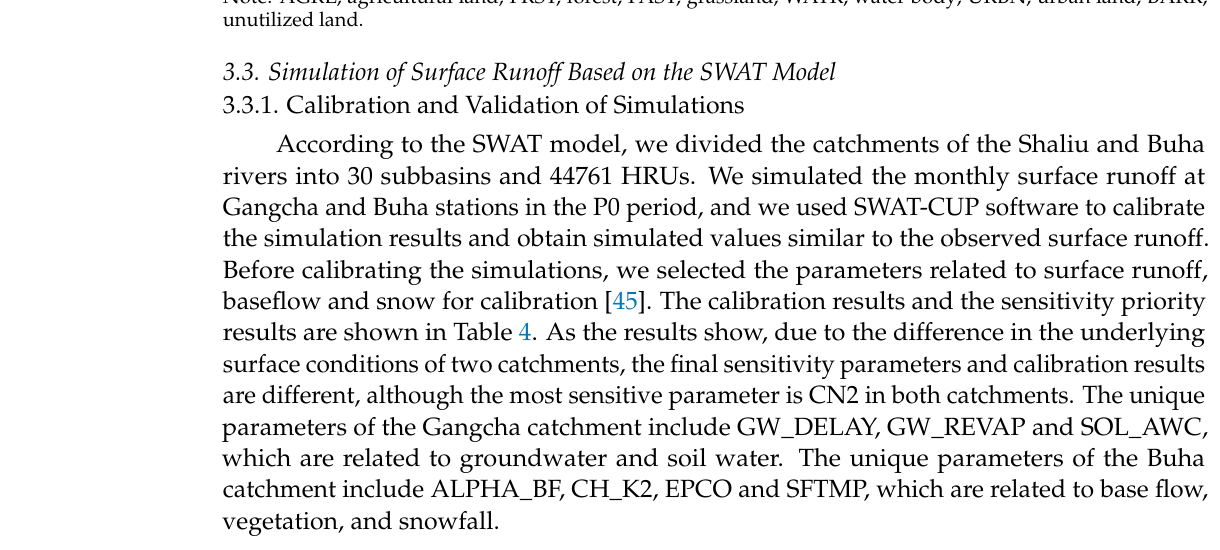
Table 4. Calibration results and sensitivity priority of the